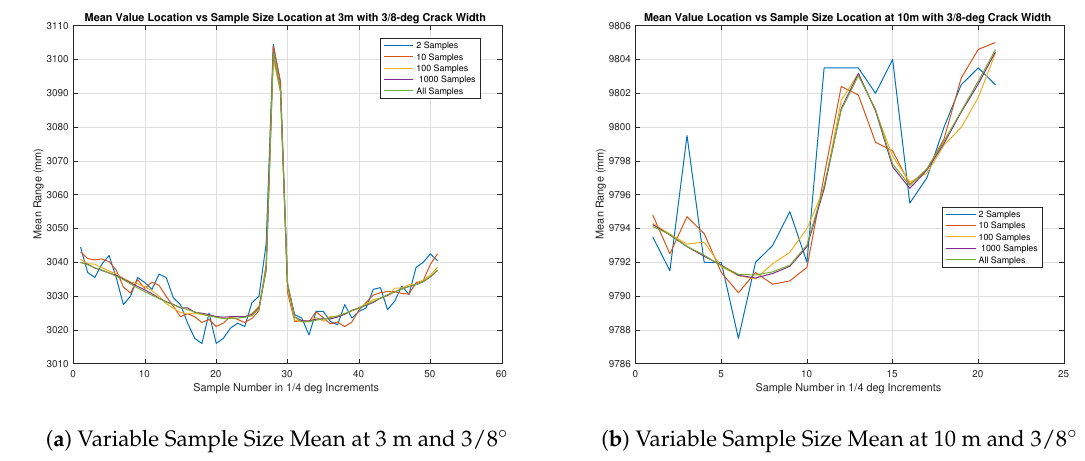
Figure 13. Comparison of Angular Resolution Results between 3 m & 10 m range at a Gap of 3/8 ◦